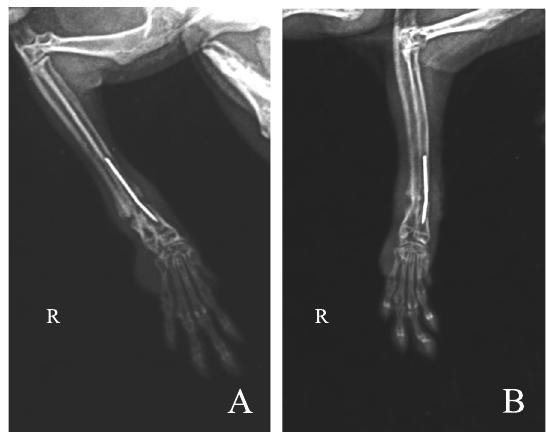
Fig. 2 Postoperative X-ray results. A Taken immediately after surgery; B Taken one month after surgery. A showed good reduction of the radius and ulna. B showed that the needle has rotation and callus growth of the radius and ulna. The ulna aligns well, but the ulna has not fully